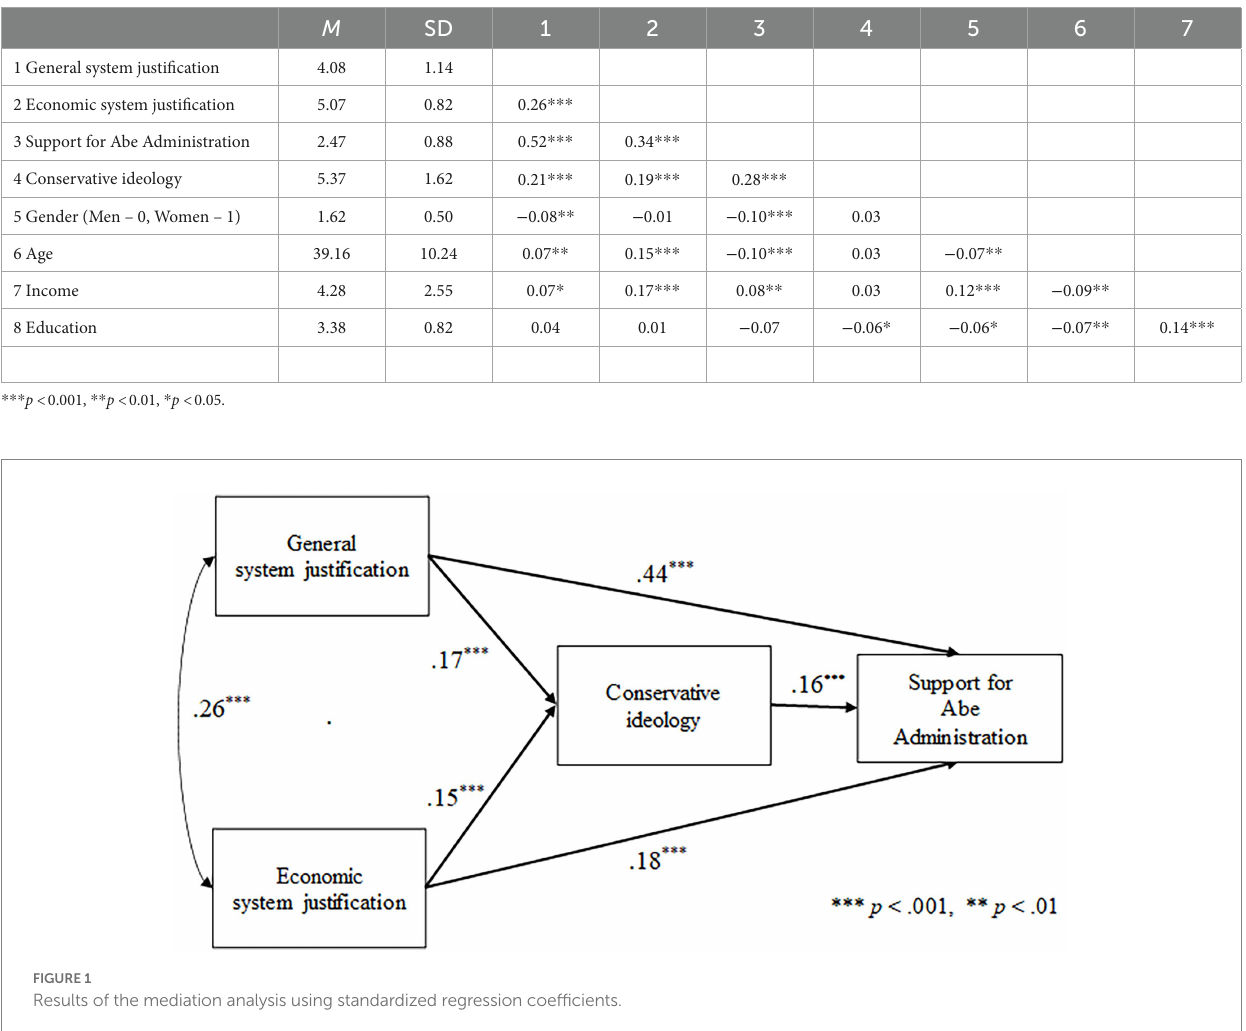
TABLE 1 Results of the correlation analysis.